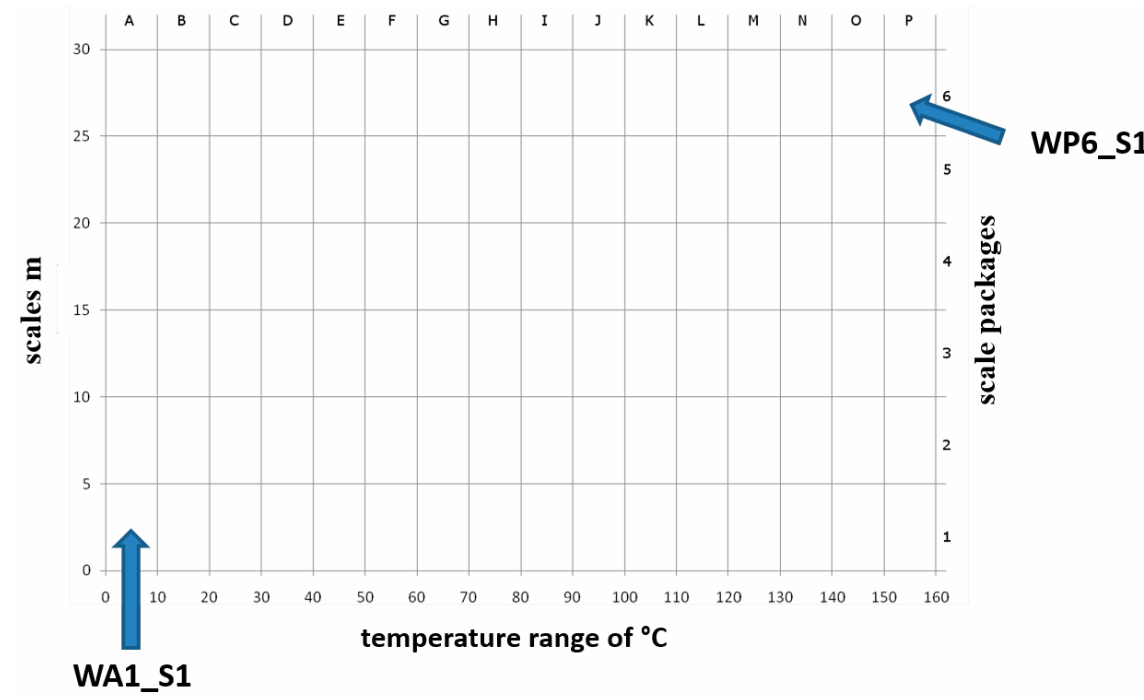
Figure 4. Scheme of WT scaling diagram (the temperature range in absolute values